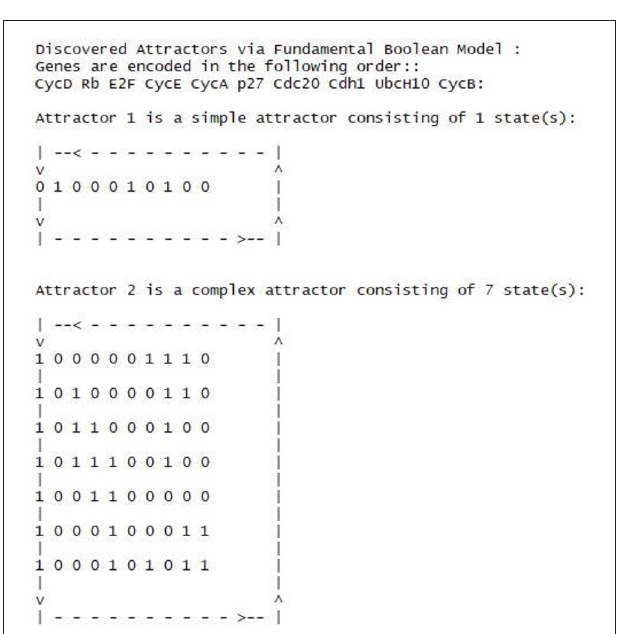
FIGURE 10 | Synchronous attractors of the cell cycle fundamental Boolean model.